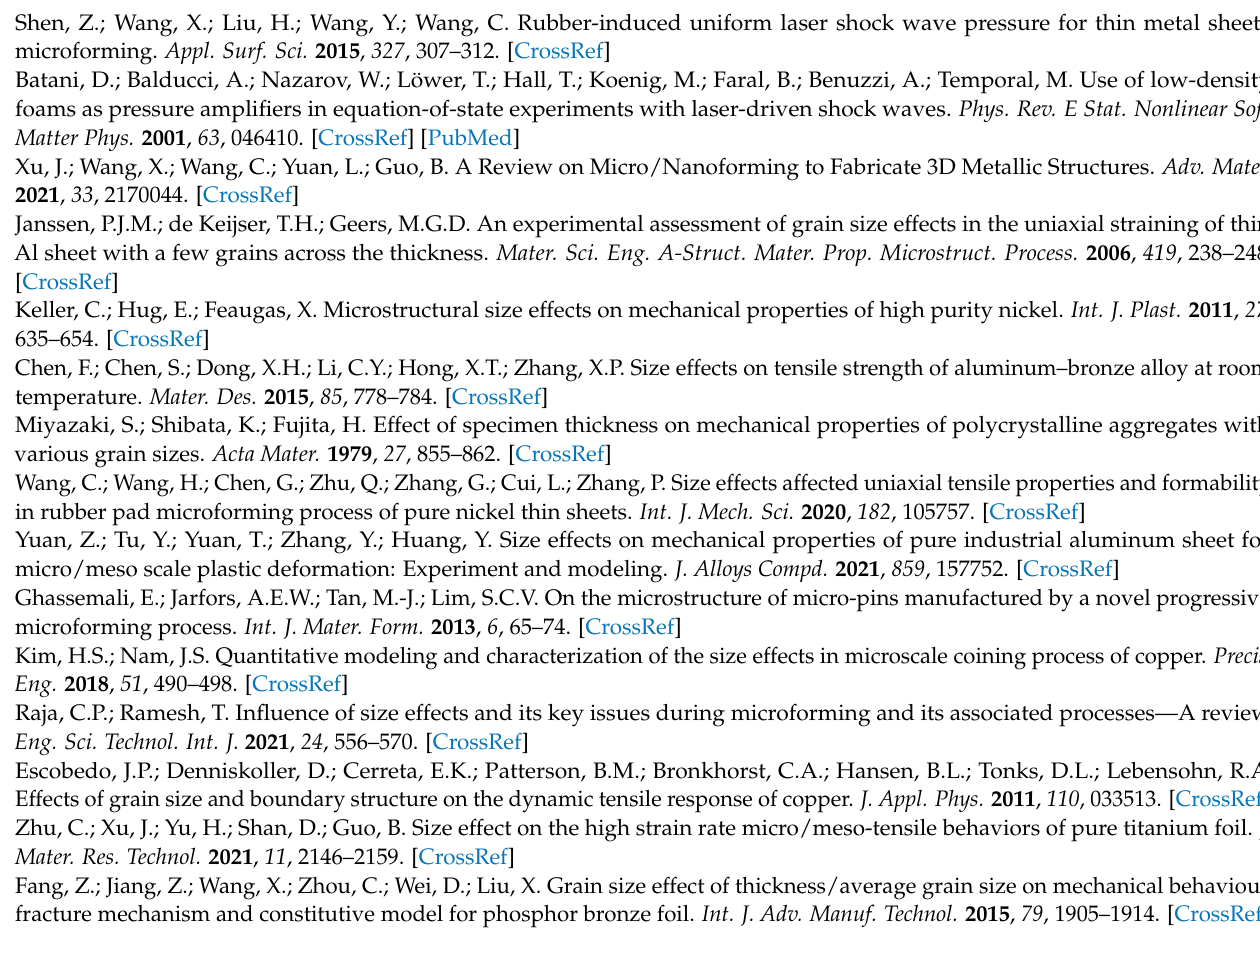
The increase of grain size and mold characteristic size leads to the increase of surface roughening rate and local necking, which is the precursor of crack. The fracture mode of bulging samples belongs to ductile fracture. (4) LPS plays a positive role in improving the surface quality and forming performance of bulging samples, which is mainly reflected in improving the forming symmetry and forming uniformity of bulging samples. The surface roughness of fine-grained bulging samples decreases from 2.267 to 1.797 µ m with an increase of 20.7% ( λ = 0.25, 363 mJ). Additionally, the maximum thinning rate of fine-grained bulging samples decreases from 67.5% to 24.5% ( λ = 0.25, 575 mJ). (5) The nano-hardness and elastic modulus of bulging samples without LPS change abnormally due to their uneven microstructure in the bulging transition zone, but there is no such phenomenon in bulging samples with LPS, which indicates that LPS can effectively improve the forming